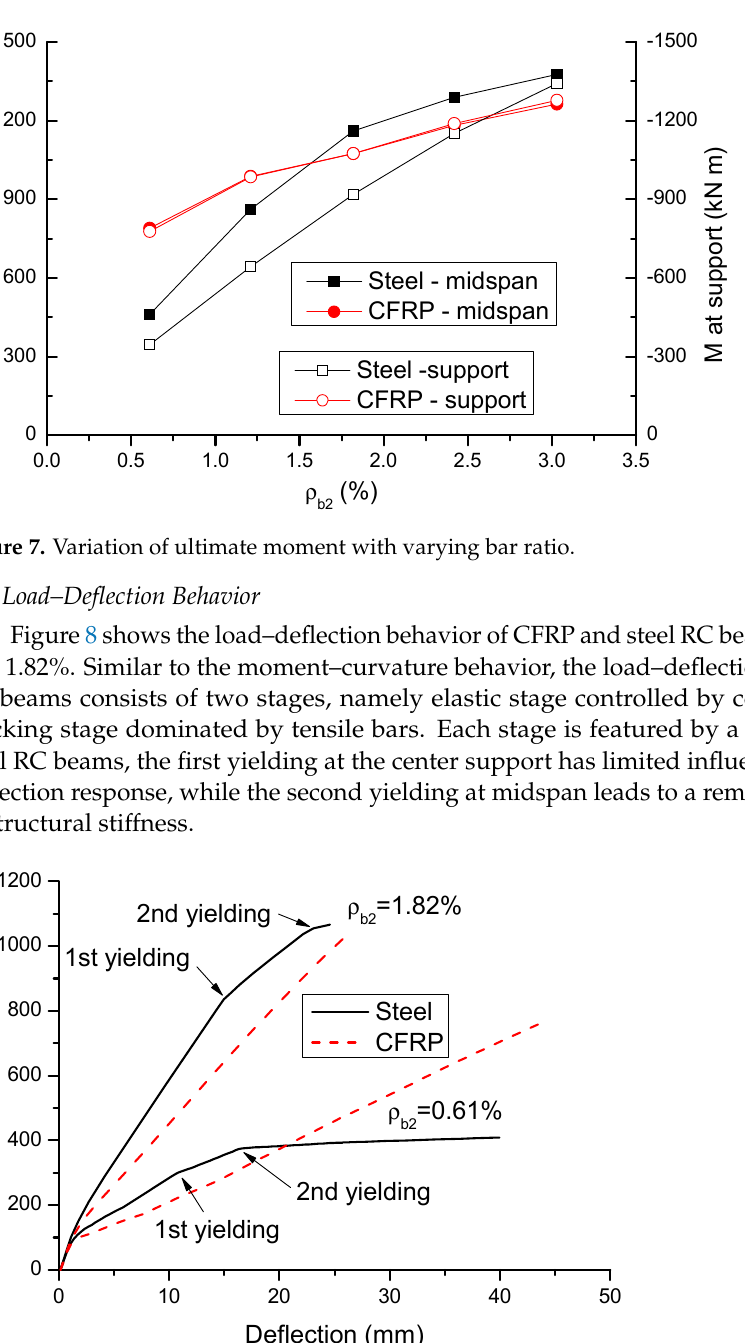
Figure 9. Variation of ultimate load with varying bar ratio. 0.0